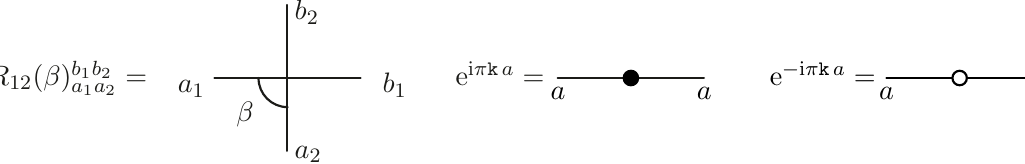
Figure 1. Graphical representation of the R -matrix (4) and the boundary twists e (cid:6) i (cid:25) k (cid:27) z . The edge indices a; a 1 ; a 2 ; b 1 ; b 2 take two values (cid:6) 1. involving the parameter k lying within the \(cid:12)rst Brillouin